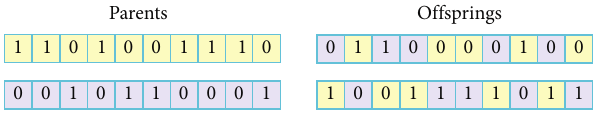
Figure 5: Uniform crossover.